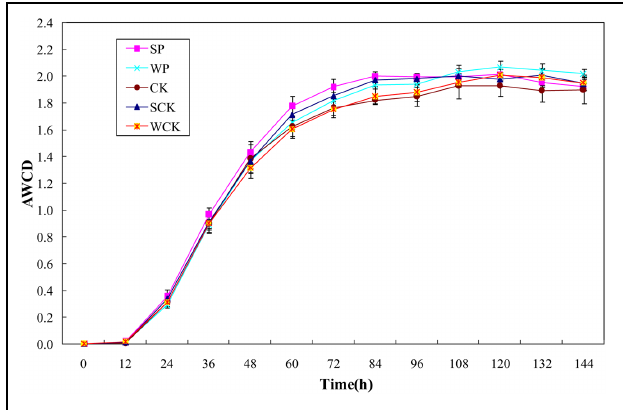
FIGURE 6 | The gene copy numbers of soil Trichoderma sp. under the different treatments. Values are means ± SD of triplicate